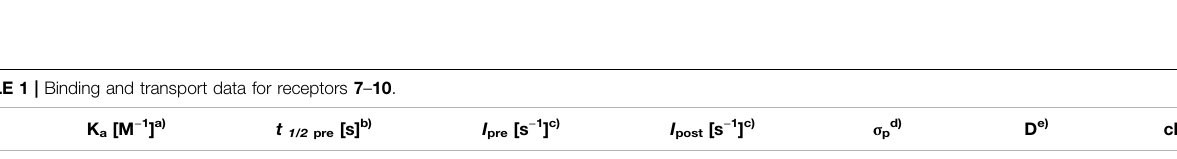
FIGURE 4 | (A) Schematic representation of the lucigenin assay; (B) changes in the relative fl uorescence F/F 0 measured during the transport of Cl − into 200 nm LUVs mediated by receptors 7 – 10 pre-incorporated in the membrane ( 7 : 400 nM, 8 – 10 : 40 nM).